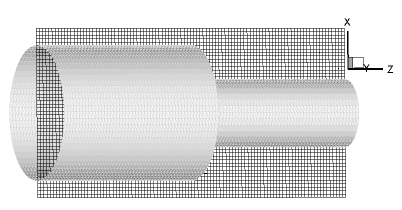
Figure 2. Sudden contraction representation through the IB